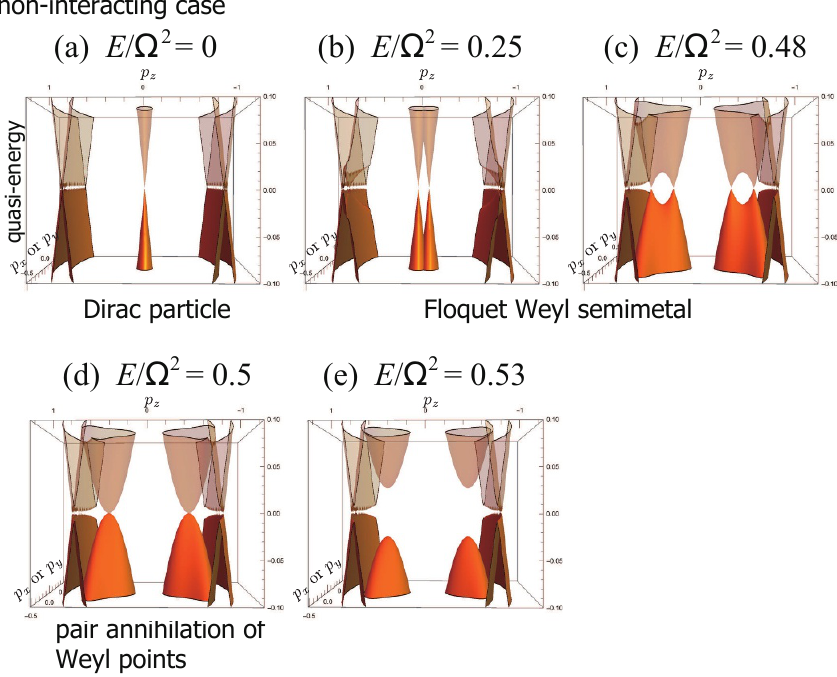
Figure 2. Quasi-energy spectrum of a noninteracting Dirac particle in rotating electric (cid:12)elds, taken from [20]. (a) At zero (cid:12)eld, spectrum of massless Dirac particles exists at ~p = 0 and the Floquet sidebands for states with energies (cid:6)j ~p j + m (cid:10) surrounds it ( m : integer). (b,c) For (cid:12)elds 0 <E= (cid:10) 2 (cid:20) 1 = 2, the Dirac spectrum splits into spectra of two Weyl fermions (1.2). At p z = (cid:6) 1, p x = p y = 0, a new sets of Weyl points emerge and move toward the two Weyl points near the